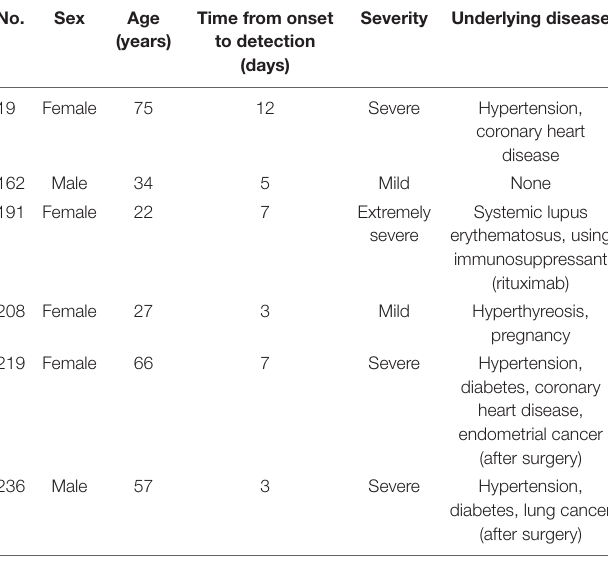
TABLE 2 | The demographic and clinical characteristics of 6 COVID-19 patients with negative anti-SARS-CoV-2 results in all 24 assays.